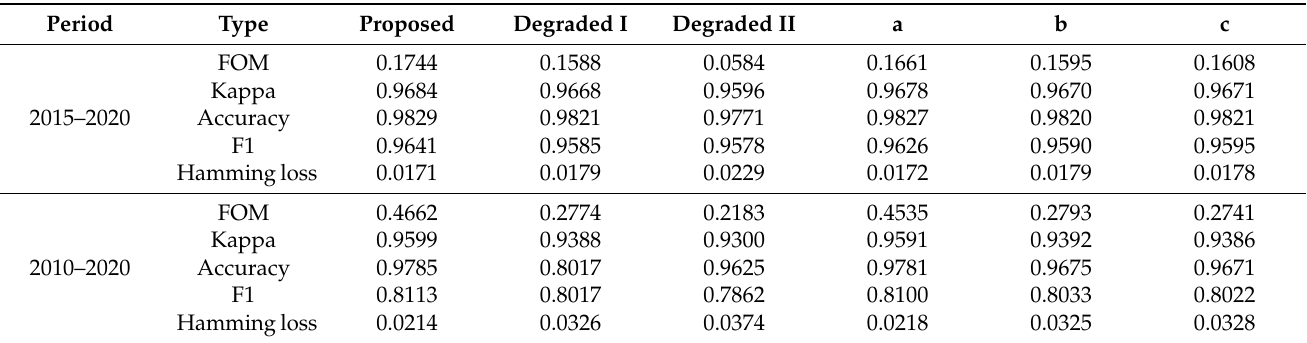
Table 4. Comparison of the simulated result using the proposed model, Degraded I model, Degraded II model, a model, b model, and c